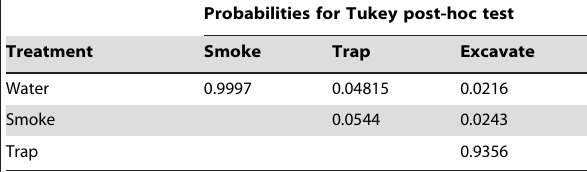
Table 1. Tukey post-hoc test between